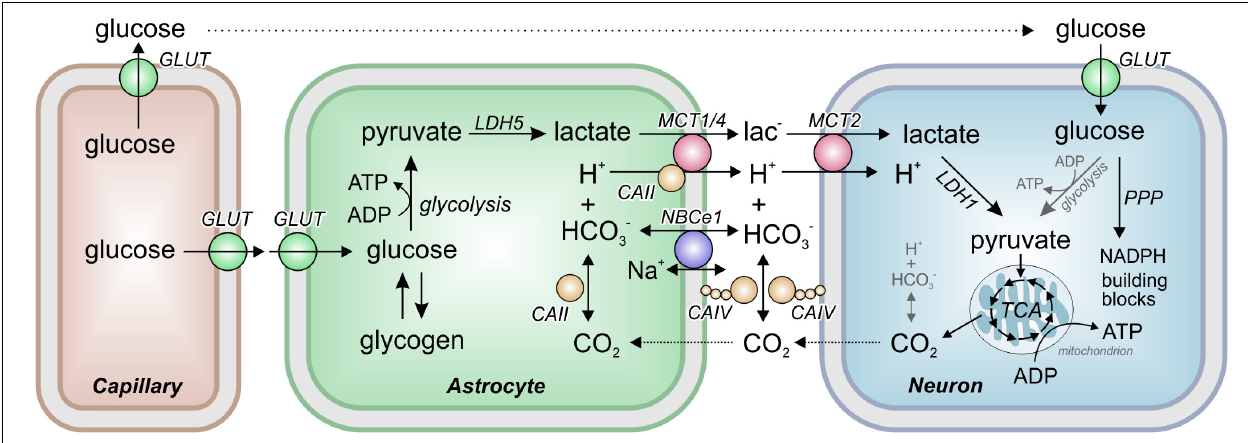
FIGURE 1 | The Astrocyte to Neuron Lactate Shuttle. Astrocytes take up glucose from the blood capillaries via glucose transporters (GLUTs). In astrocytes, glucose is either stored as glycogen or metabolized to pyruvate in the glycolysis. Pyruvate is then converted to lactate by the oxidoreductase lactate dehydrogenase (LDH) isoform 5 (LDH5). The lactate is transferred from astrocytes to neurons by the monocarboxylate transporters (MCTs) MCT1, MCT2, and MCT4 in cotransport with a proton. MCT transport activity was found to be facilitated by interaction with the carbonic anhydrases (CAs) CAII and CAIV, which catalyze the equilibrium of H + , HCO 3 − and CO 2 both intra- and extracellularly, and by the activity of the electrogenic sodium-bicarbonate cotransporter NBCe1. In neurons, lactate is converted back to pyruvate by LDH1 and transferred into mitochondria for aerobic energy production in the tricarboxylic acid cycle (TCA). In addition, glucose is directly taken up into neurons where it can either serve as energy source in the glycolysis or is shuttled into the pentose phosphate pathway (PPP) for production of NADPH and cellular building blocks like ribose-6-phosphate.